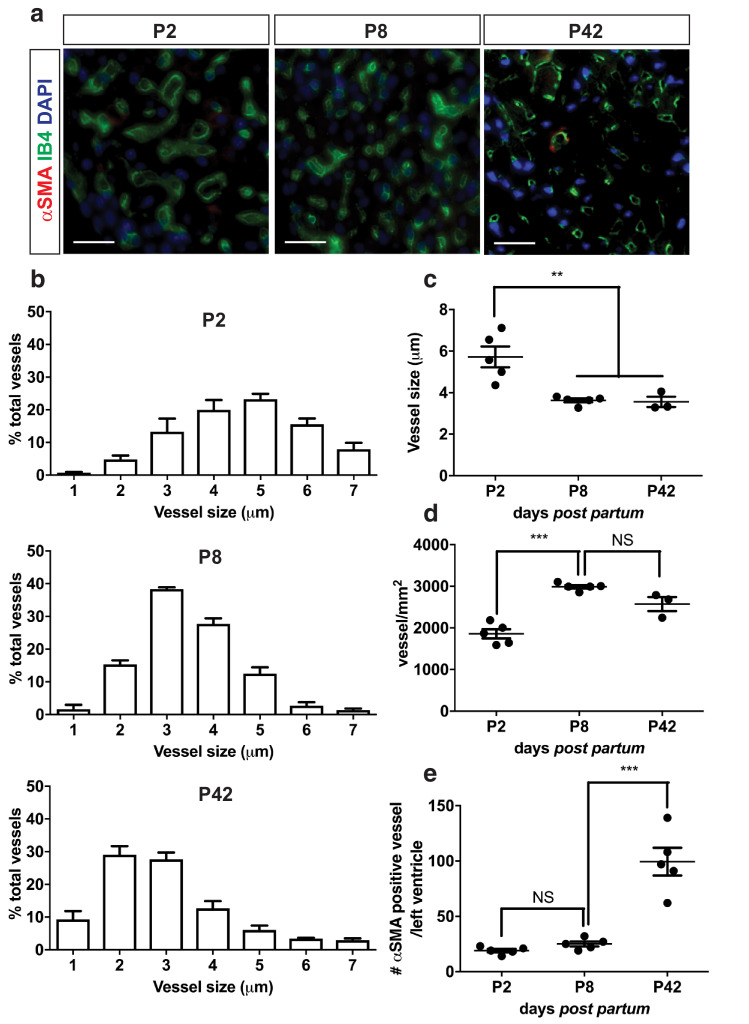
Vessel size, density and maturation in the post-natal mouse heart. Vessel size, density and maturation were investigated on isolectin B4 (IB4; green-endothelial cells), α-smooth muscle actin (αSMA; red-mural cell coated vessels) and 4′,6 diamino-2-phenylindole (DAPI; blue). Quantification of vessel size and density was performed on five different field of views within the outer layer of the left ventricle on 4 μm thick stained sections at post-natal day 2 (P2), P8 and P42. (a) Representative images; scale bars = 50 μm. (b) Vessel size distribution was investigated at the three chosen time points. (c) Average vessel size in micrometres. (d) Vessel density was expressed per square millimetre of myocardium. (e) Number of αSMA+ve vessels within the whole left ventricle; n = 3–5/group. Results are presented as mean ± standard error of the mean; p value determined with one-way analysis of variance with Bonferroni post hoc test; p > 0.05 (nonsignificant), **p < 0.01, ***p < 0.001.